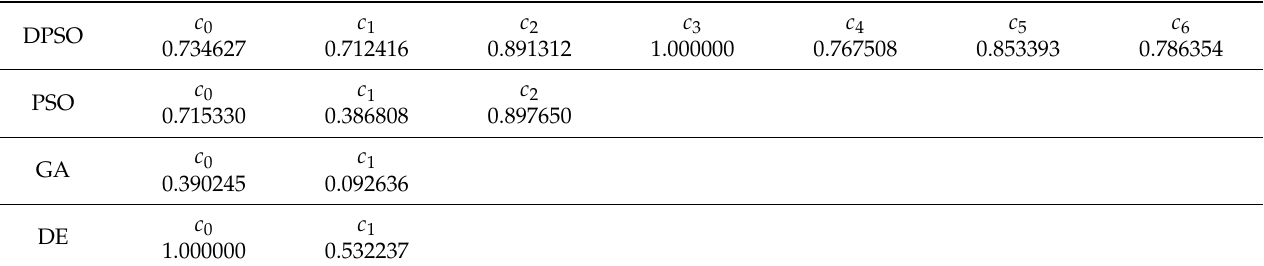
Table A3. Global best self-tuning parameters for 21 dimensions.